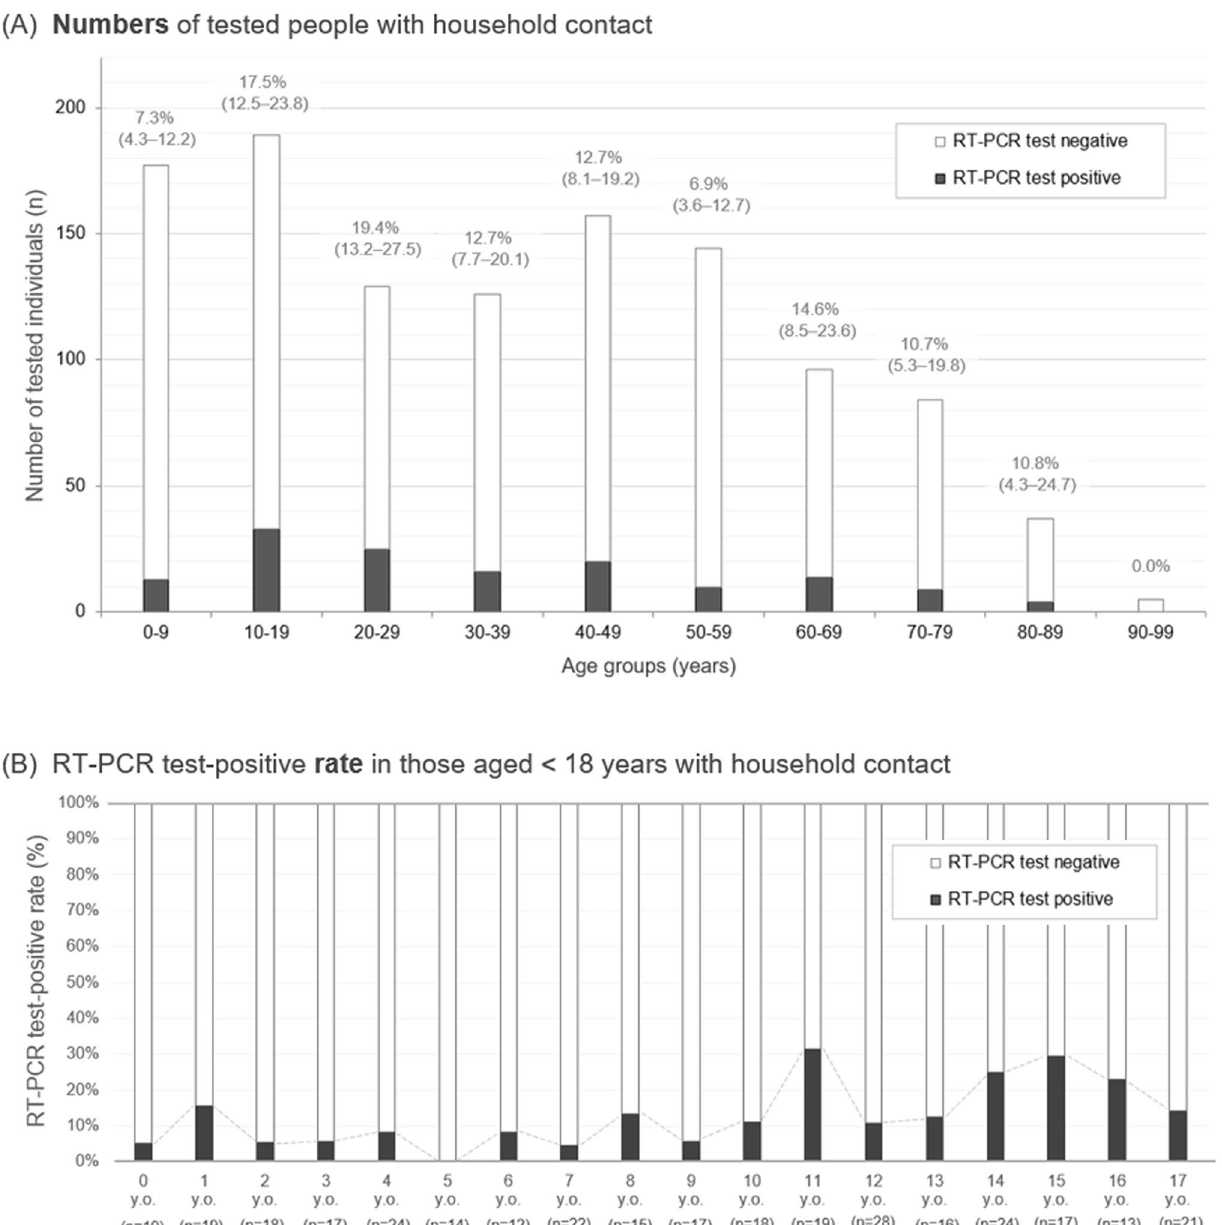
Figure 4. Histogram of tested individuals after household contact with a patient with COVID-19 by age group. The figures present ( A ) a histogram of the number (n) of tested individuals after household contact with a family member with COVID-19 separated into 10-year age intervals among all 1144 enrolled individuals with household contact. ( B ) RT-PCR test-positive rate (%) by age after household contact in 333 non-adults aged < 18 years. Black bars represent the proportion of positive RT-PCR test results, and white bars above the black bars illustrate the proportion of negative RT-PCR test results. The percentage and range shown in panel ( A ) indicate the proportion of positive RT-PCR tests and the 95% confidence interval in each age group,